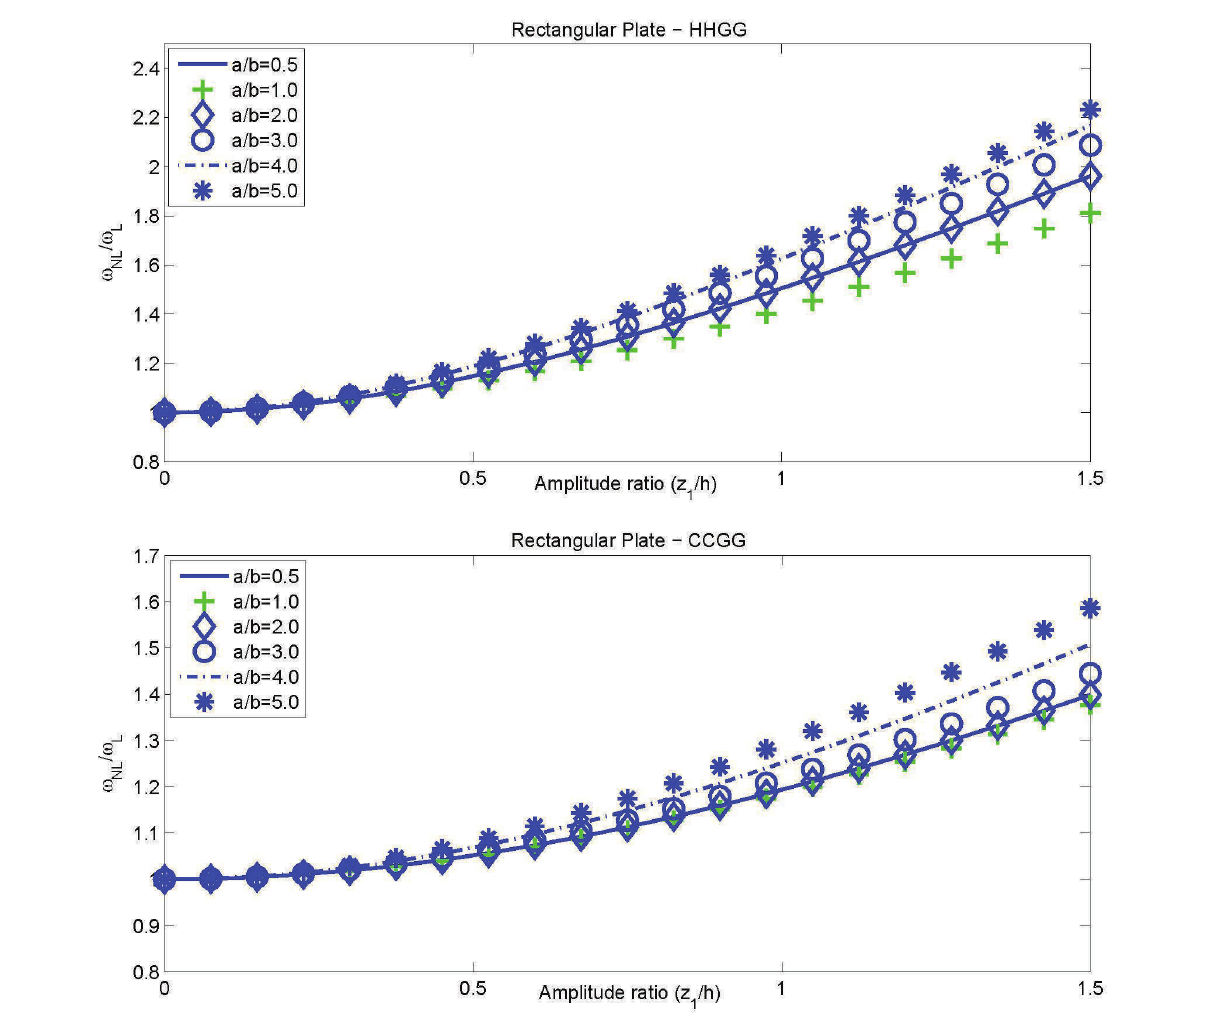
/ of various rectangular plates obtained by using the b